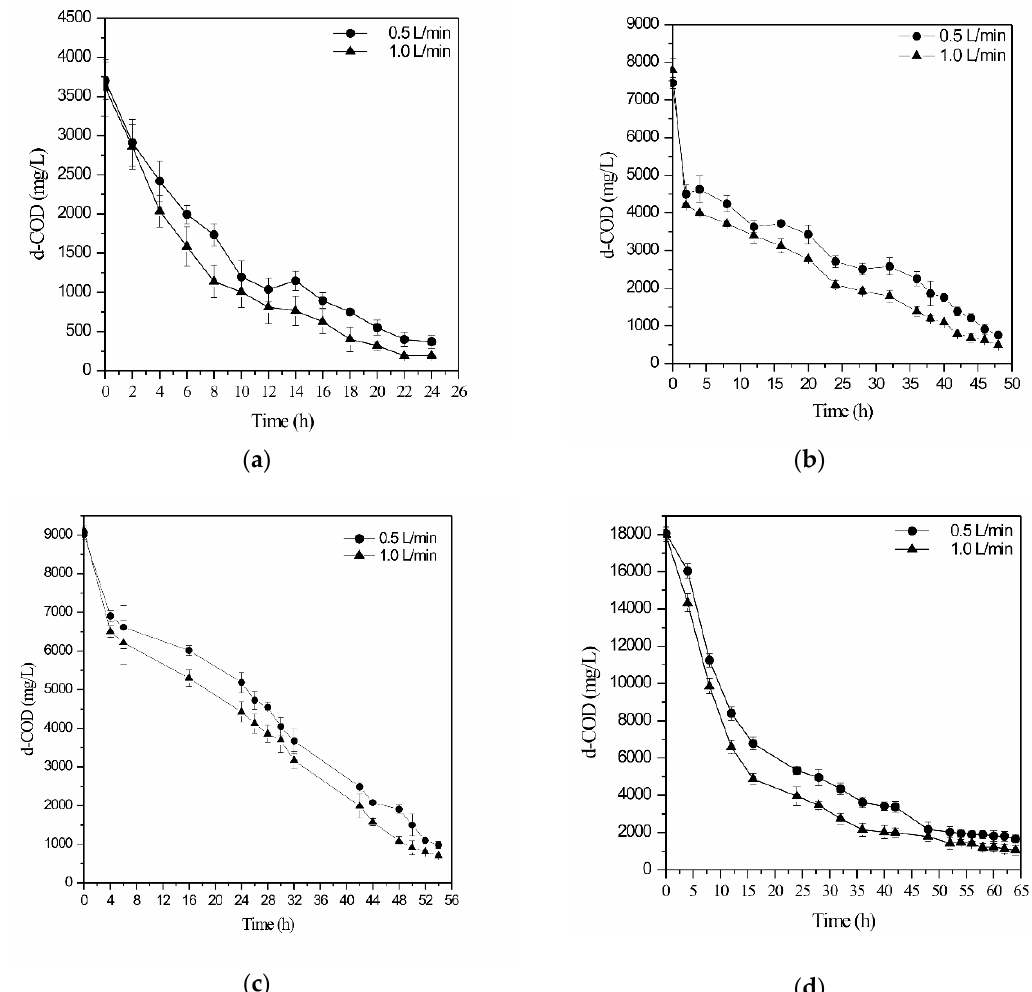
Figure 3. d-COD concentration in the trickling filter under batch operating mode with recirculation rates of 0.5 and 1.0 L/min for initial d-COD concentrations of: ( a ) 3500 mg/L ( b ) 7500 mg/L ( c ) 9000 mg/L and ( d ) 18,000 mg/L.